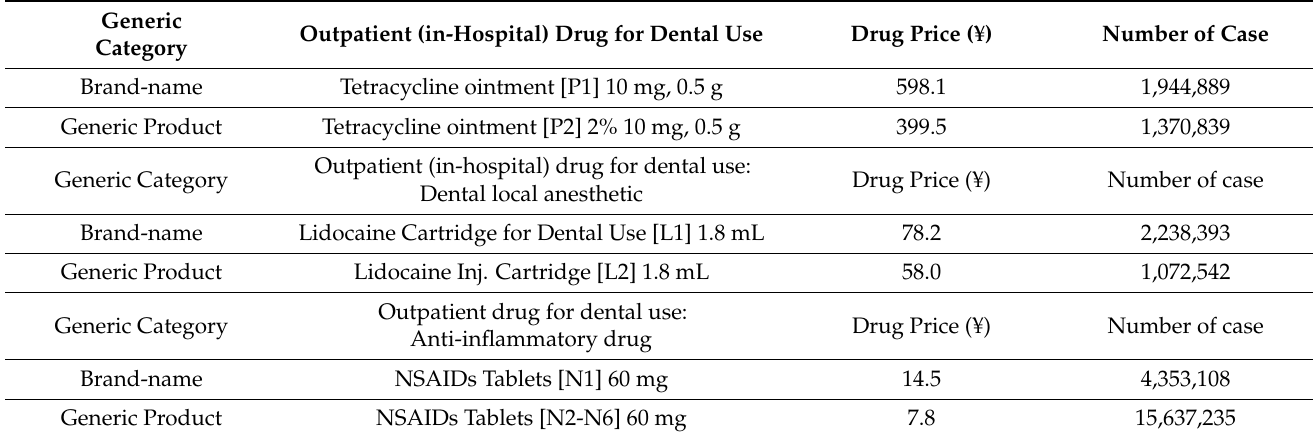
Table 1. Drug combinations used to calculate the percentage of generic drug